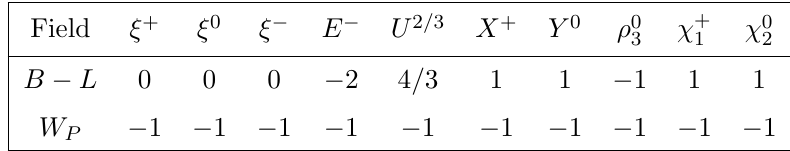
Table 2 . Nontrivial B (cid:0) L charge and matter